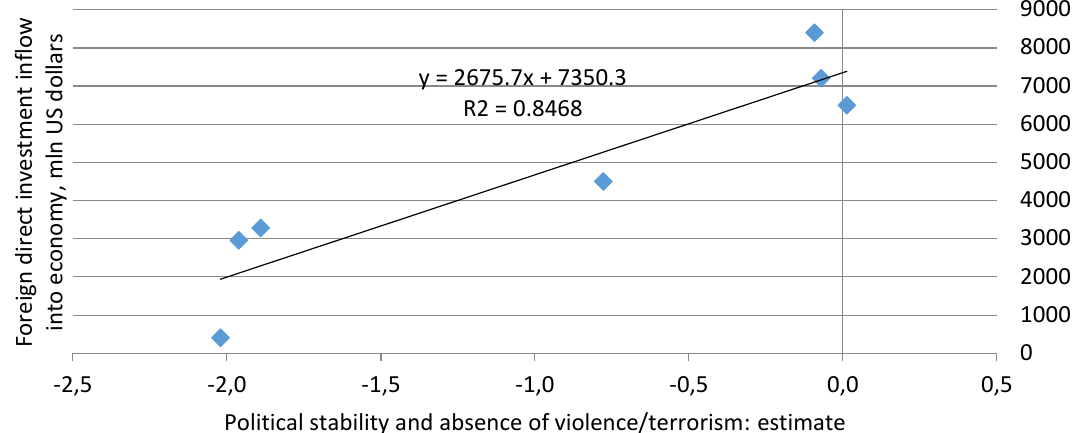
Figure 3. Regression model of dependence of the foreign direct investment flows into the economy upon the indicator of political stability and the absence of violence in Ukraine for 2010–2016